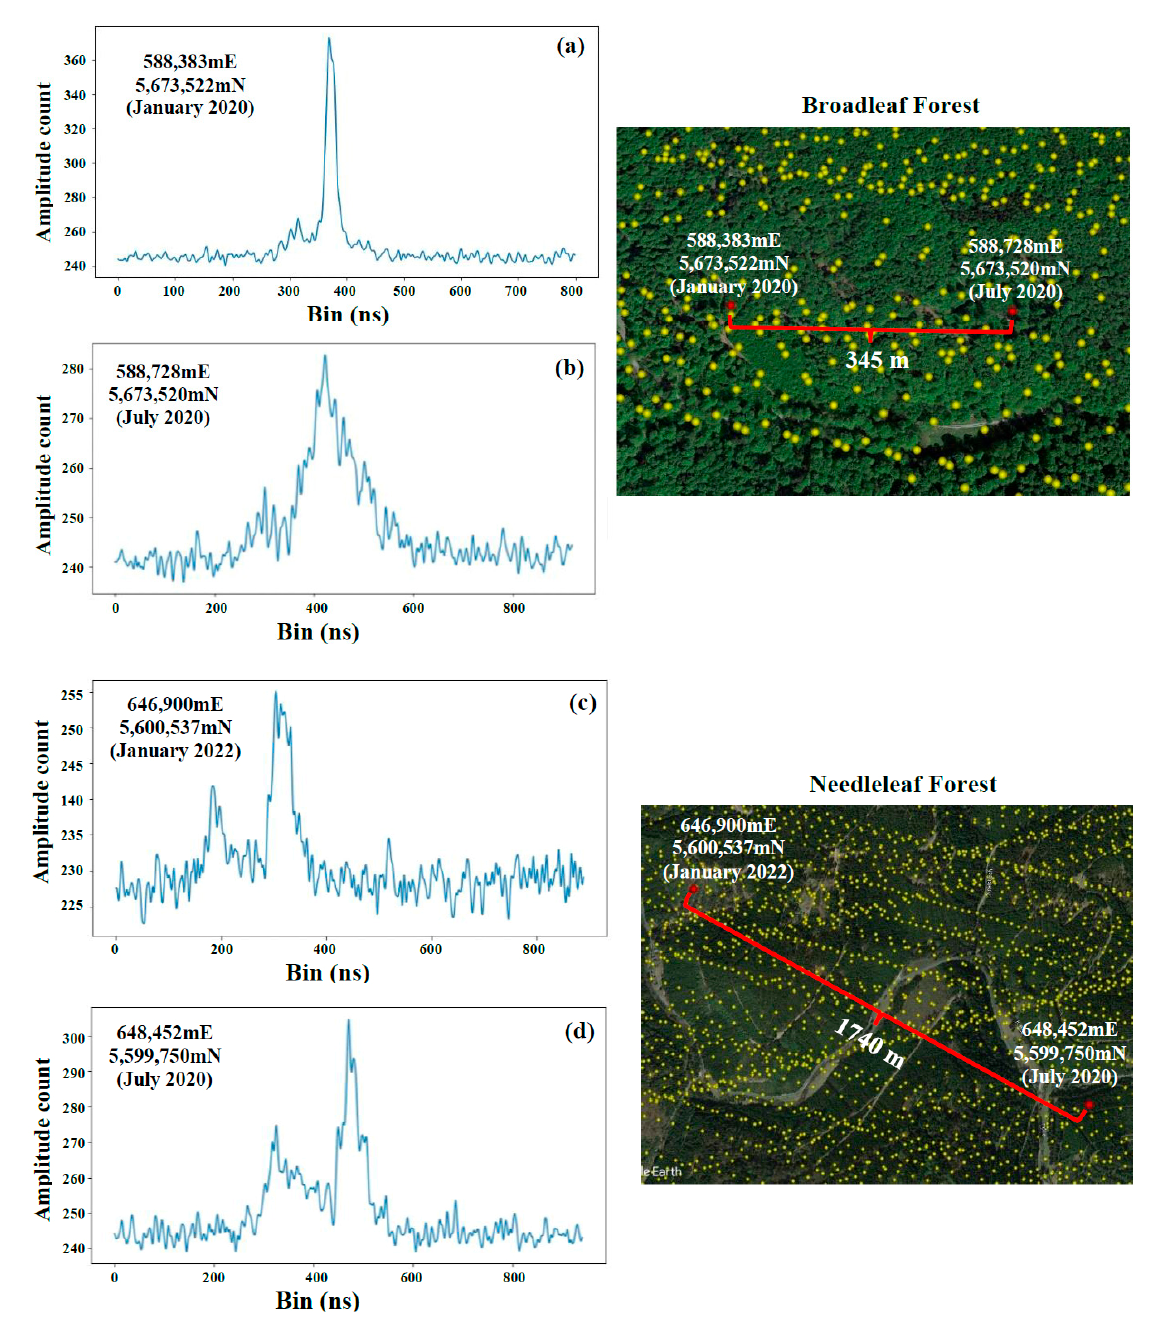
Figure 2. Examples of acquired GEDI waveform over broadleaf: ( a ) leaf-off, ( b ) leaf-on; and needleleaf: ( c ) winter, ( d ) summer. Location and acquisition date (year/month) of used GEDI waveforms and the distance between two dates in each forest type is noted.